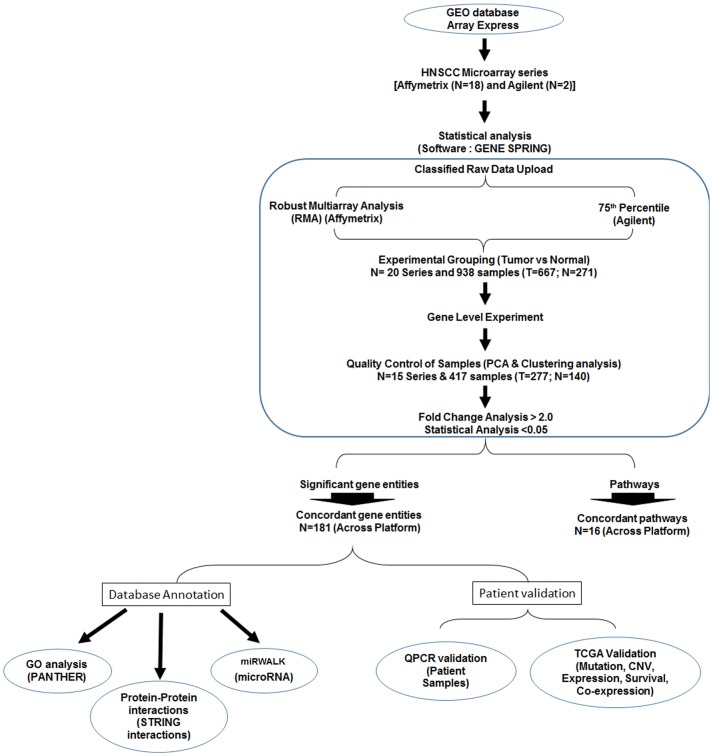
Meta-analysis work flow.The publically available raw microarray data of Head and Neck Squamous Cell Carcinoma (HNSCC) series were downloaded and grouped and analyzed in Genespring statistical software. Normalization was carried out on the samples, which were then grouped into tumor and normal prior to performing the gene level experiment. Principal Component Analysis (PCA) was performed to remove the discordant samples. Fold change and p value were calculated to obtain the significant gene entities. These statistically significant entities were used for further analysis; database annotations (Gene Ontology, STRING and miRWALK) and patient validation (Experimental validation by Quantitative Real Time PCR (qPCR) and The Cancer Genome Atlas (TCGA)).